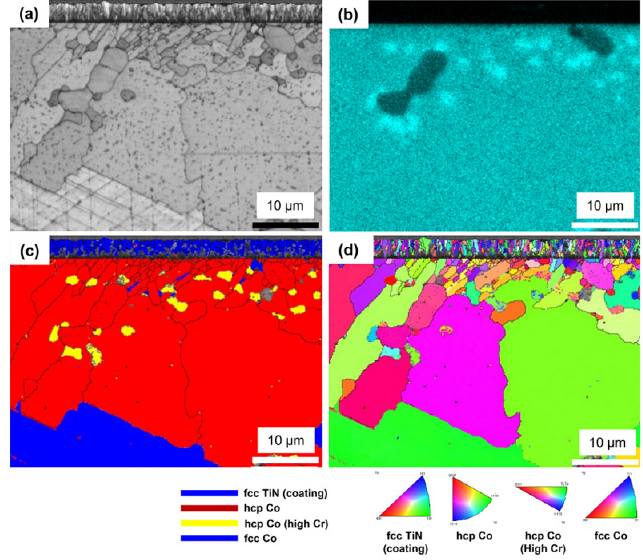
Figure 9. Cross-sectional high-magnification images of the CVD TiN-coated Co–Cr alloy analyzed using EBSD and EDS simultaneously: ( a ) BC map; ( b ) EDS map of Cr; ( c ) phase map; and ( d ) IPF map.